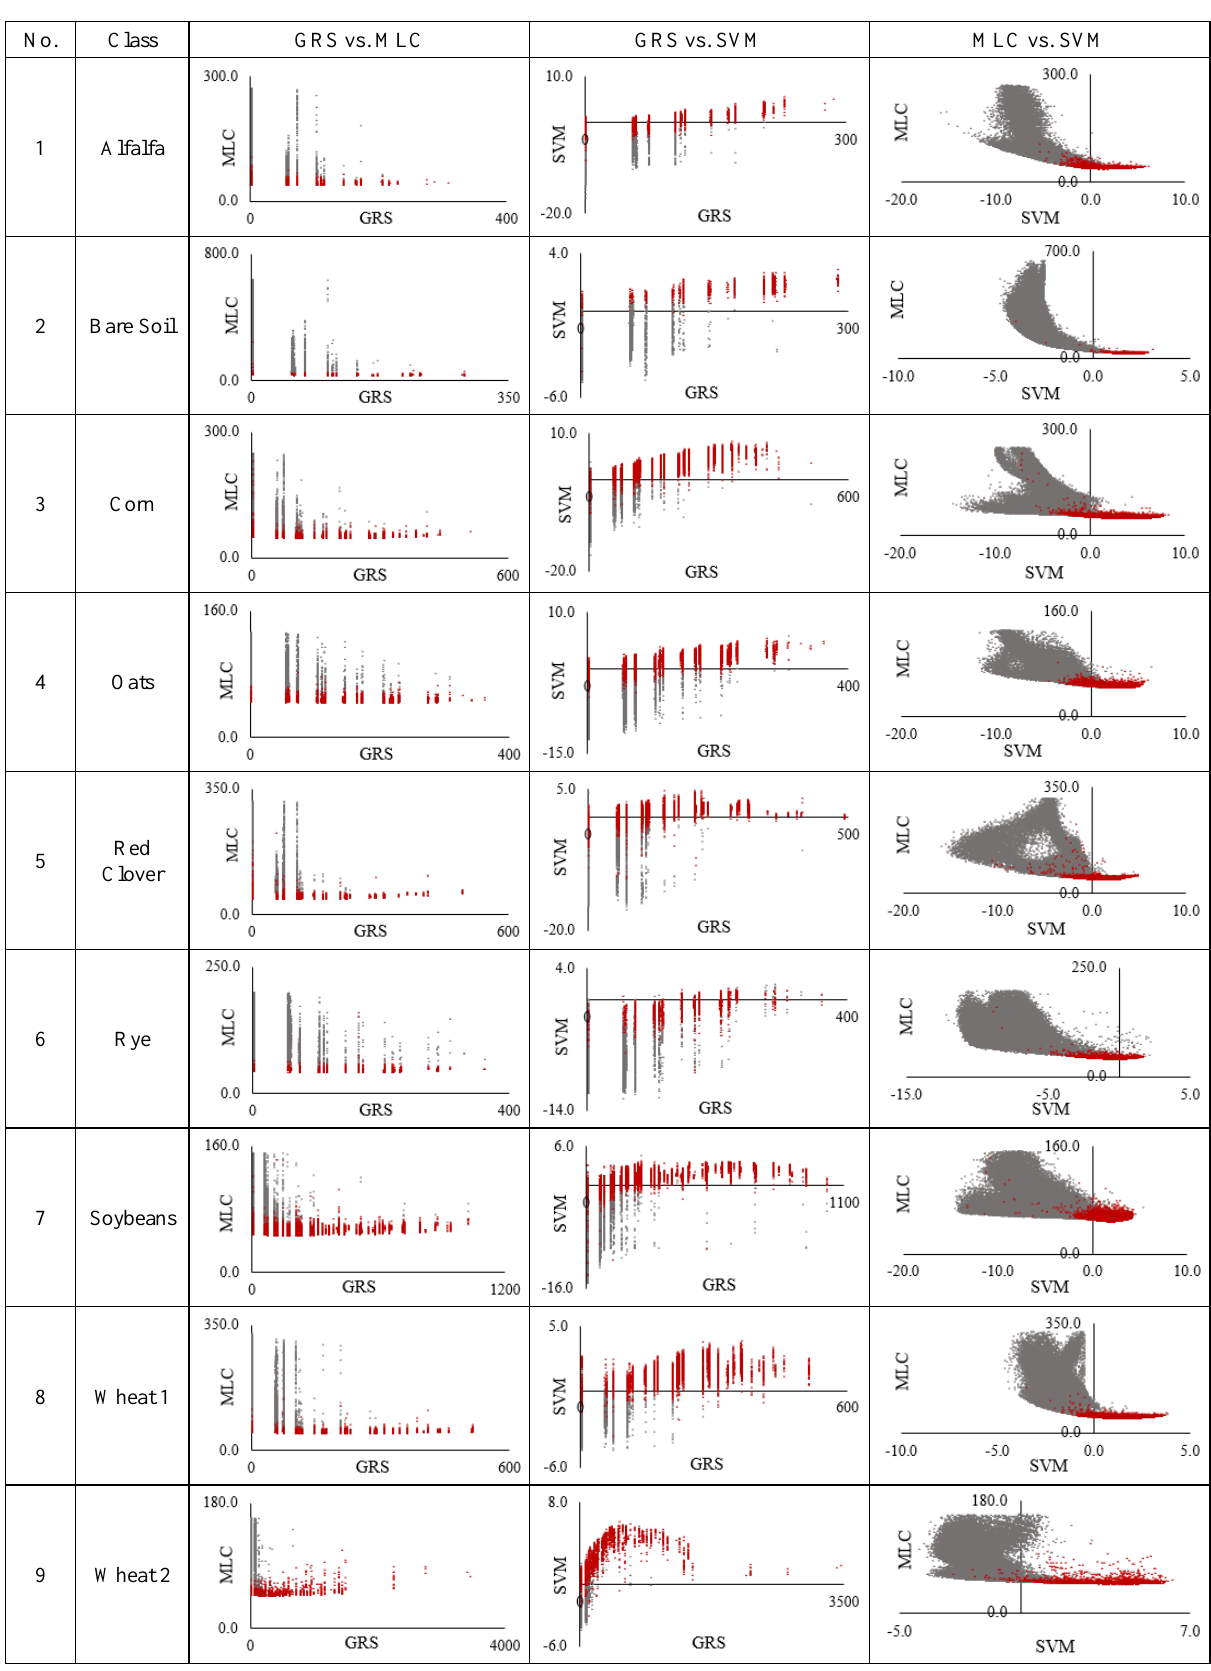
Figure 2. Scatter plots of membership between two